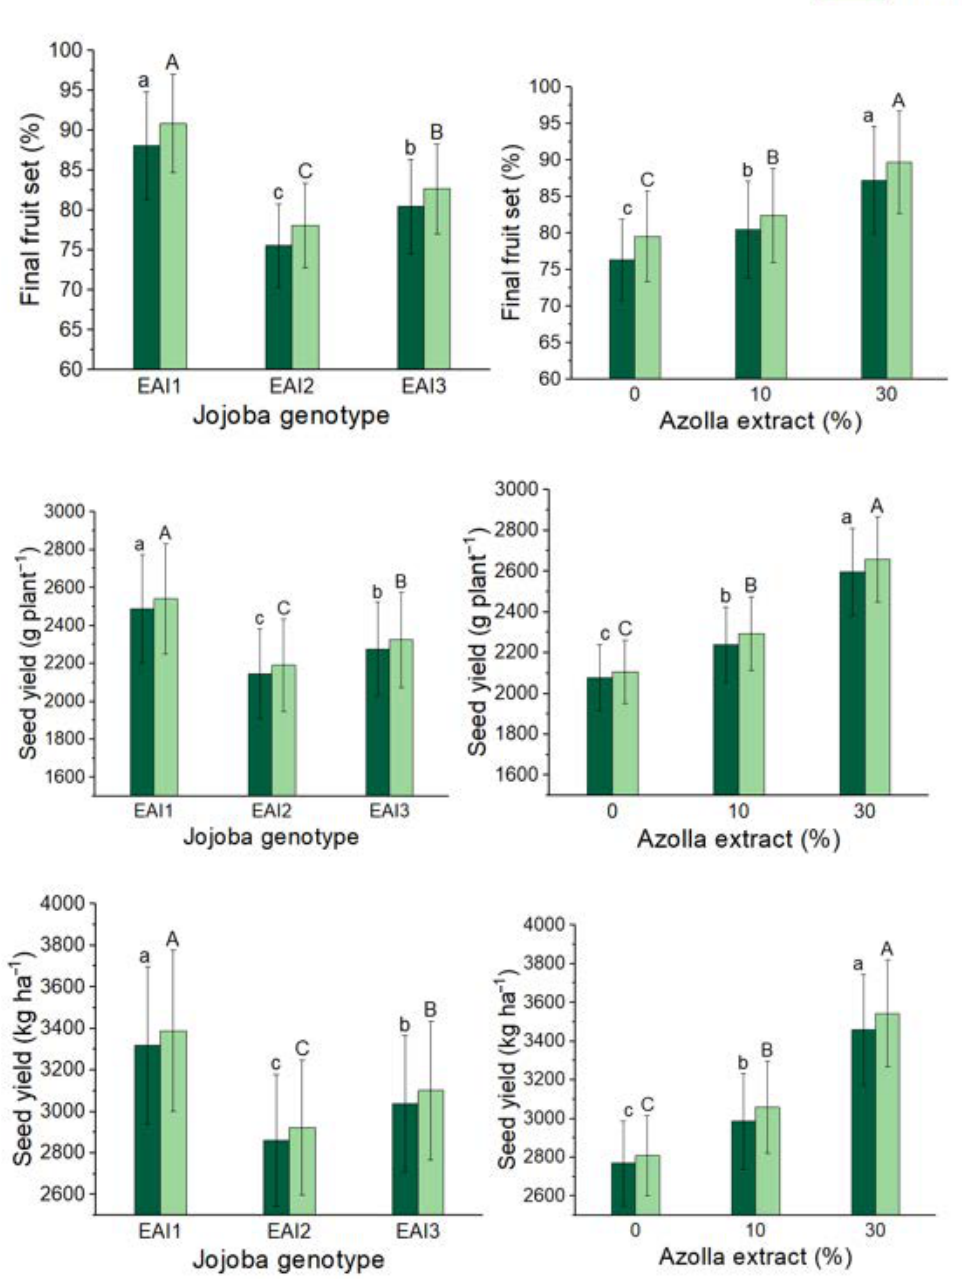
Figure 3. In both seasons, the mean values of final fruit set (%), seed yield (g plant − 1 ), and seed yield (kg ha − 1 ) of jojoba shrubs were modified by plant genotypes and foliar application of Azolla filiculoides Lam. plant extract respectively. The data are expressed as a mean value fruit set (%), seed yield (g) planting and fruit set parameters in both seasons. At the 0.05 level, bars with identical letters are not